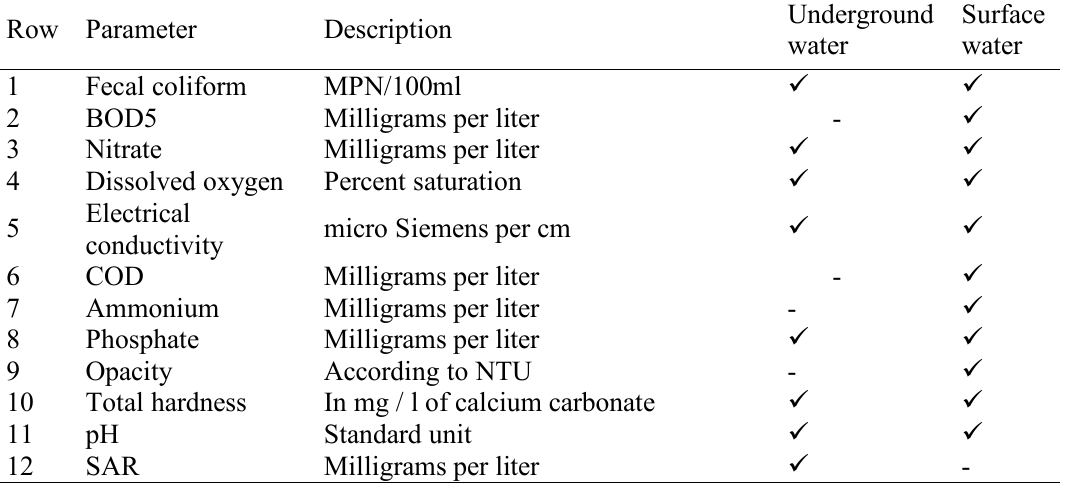
Table 3. Parameters measured by common contamination of surface water and underground water